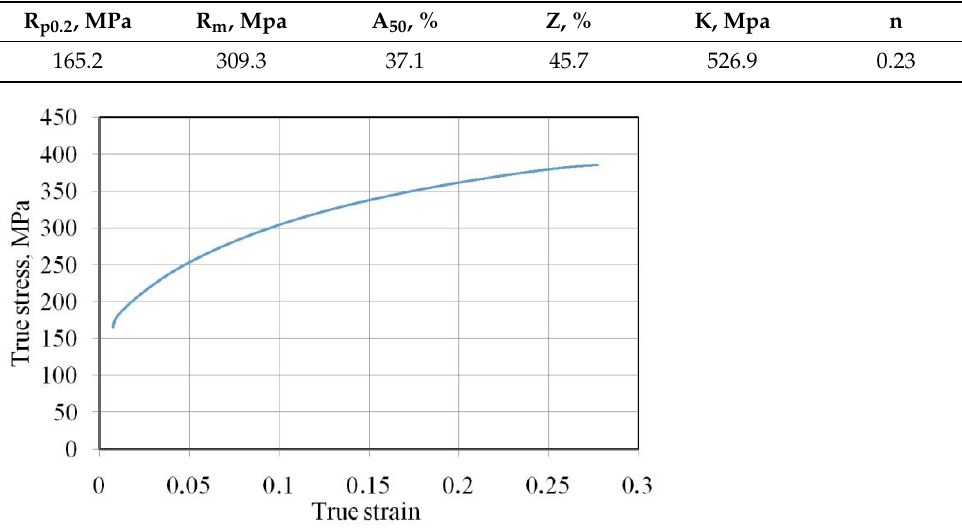
Figure 1. True stress vs. true strain curves for the DC04 steel sheet.